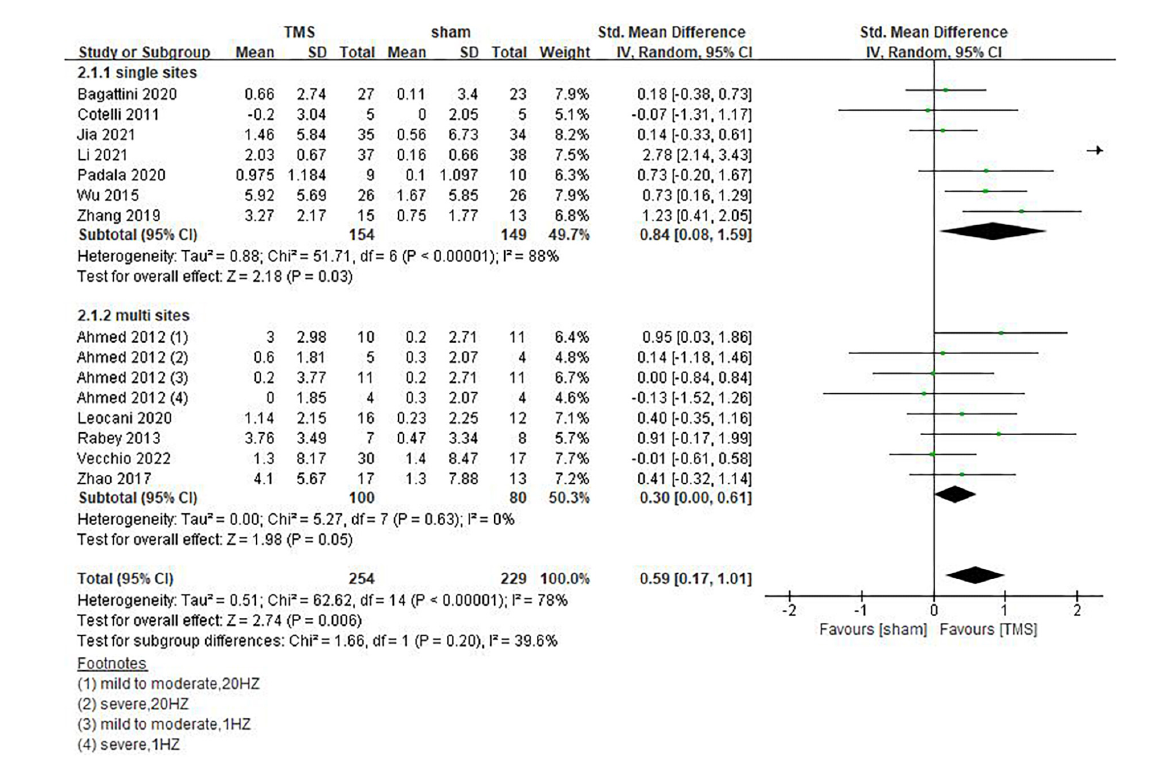
FIGURE5 Impact of repetitive transcranial magnetic stimulation (rTMS) stimulation site of rTMS on global cognitive